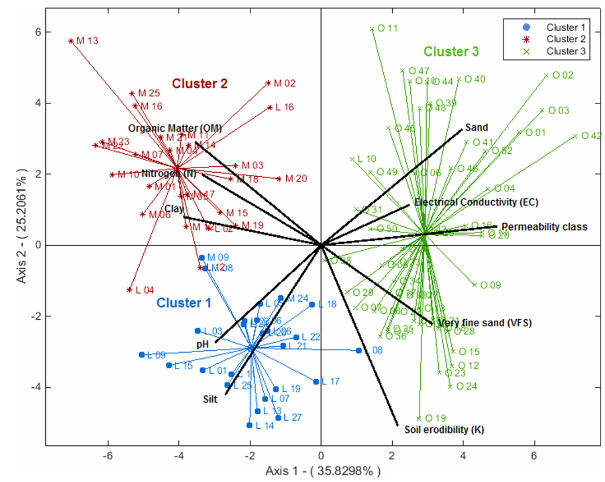
Figure 5. Hierarchical clusters representation of soil samples and studied